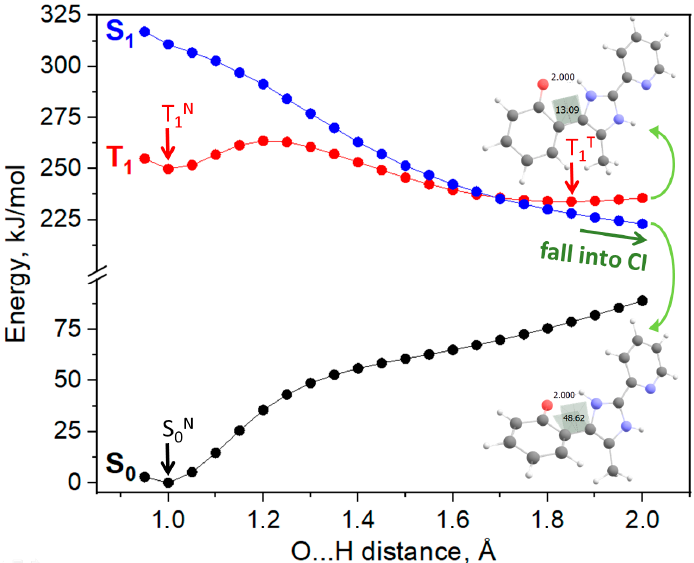
Figure 4. The potential energy surfaces (PESes) of the S 0 ( a ) and T 1 ( b ) states of L OH,OH along the